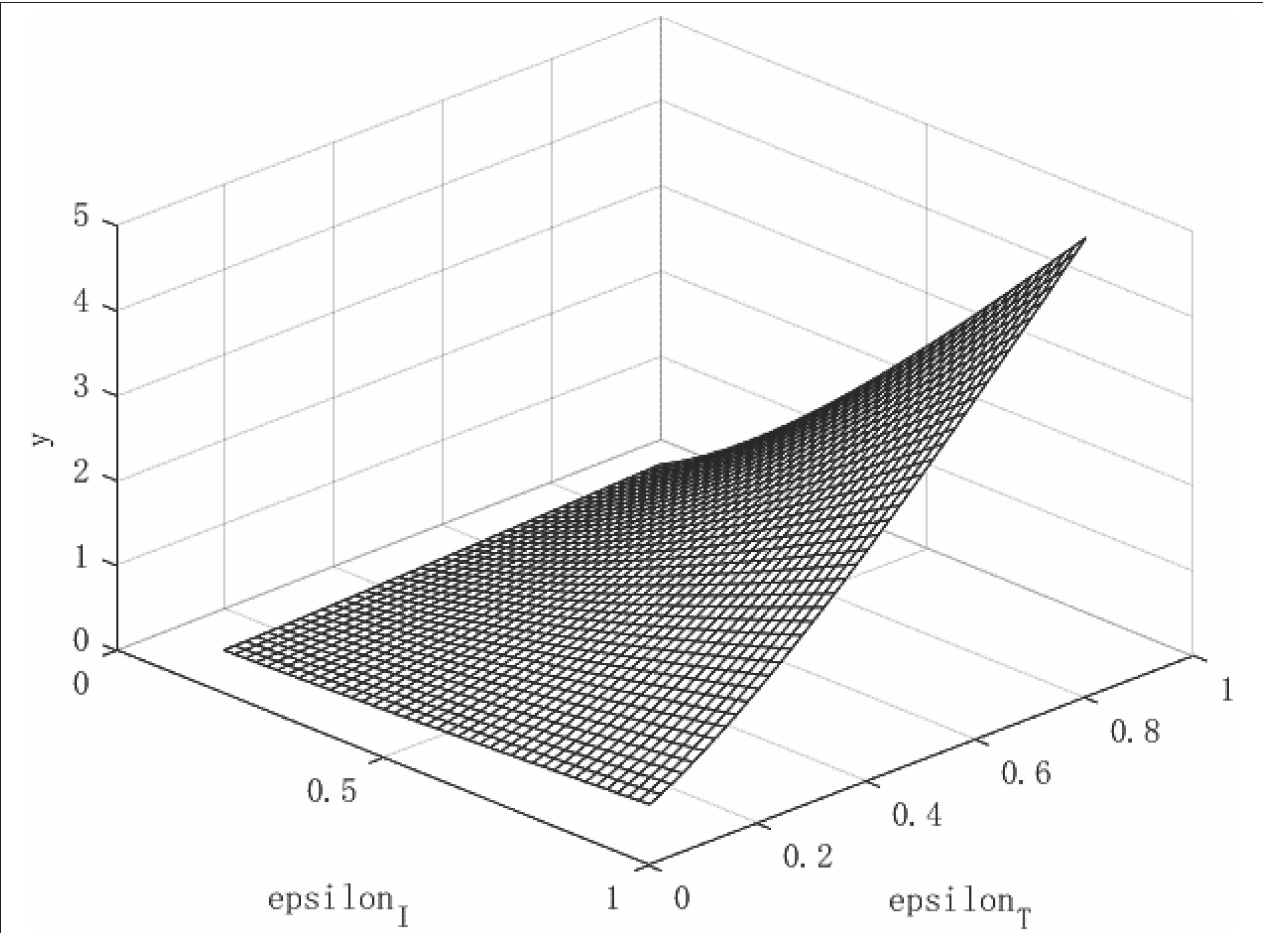
FIGURE 3 | Growth path of per capita output under